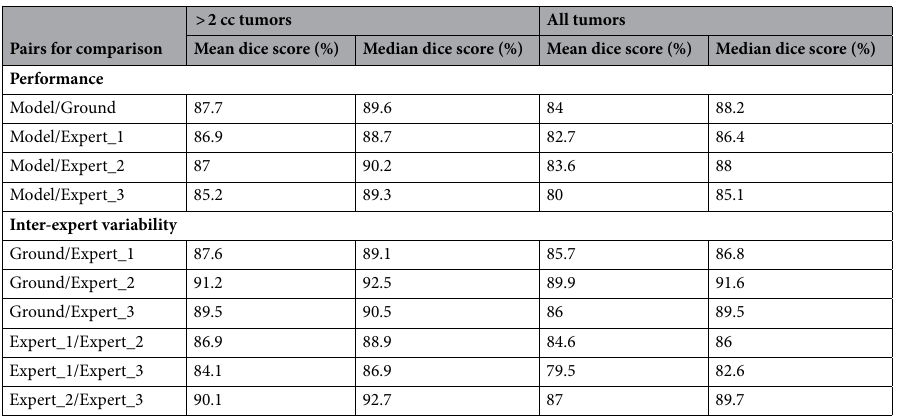
Table 1. Algorithm performance and inter-expert variability. Comparison of tumor segmentation performance (Dice scores) between algorithm output, ground truth and clinical experts (Expert_1(VK), Expert_2(TN), Expert_3(PJ)), expressed as mean and median for all tumors and tumors of volume > 2 cc. Ground : Ground truth.